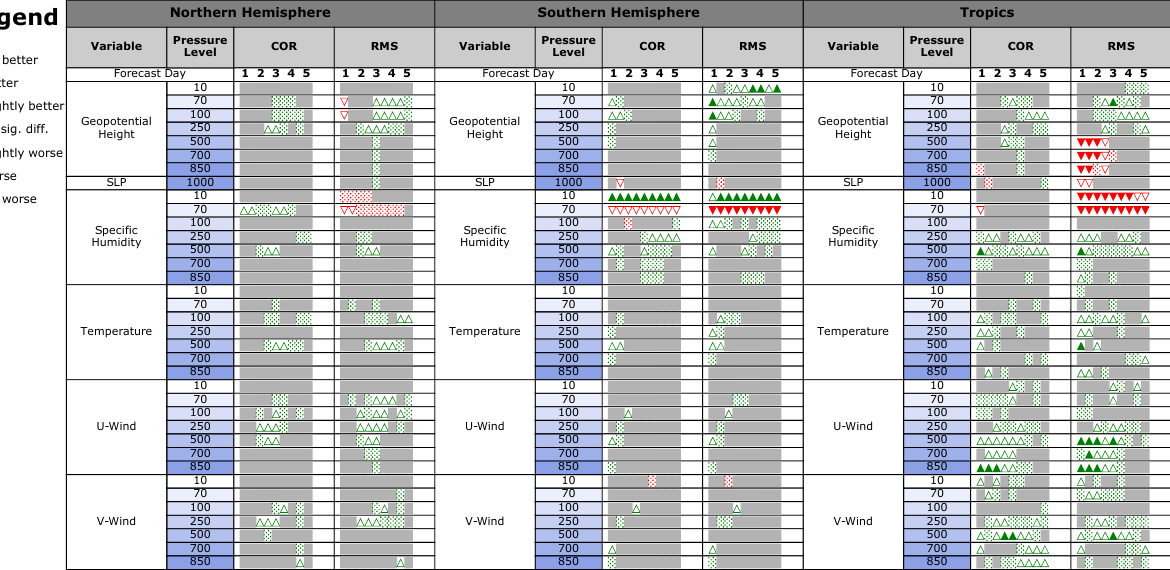
Figure 13. Same as in Figure 12, but for comparing the experiment that adds GK2A AMVs (GK2AHE) with the baseline experiment